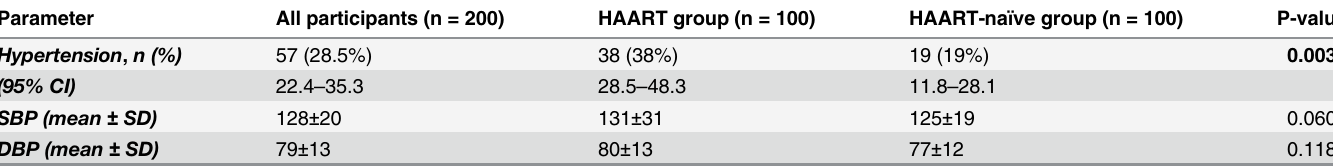
Table 2. Prevalence of hypertension and the mean blood pressure